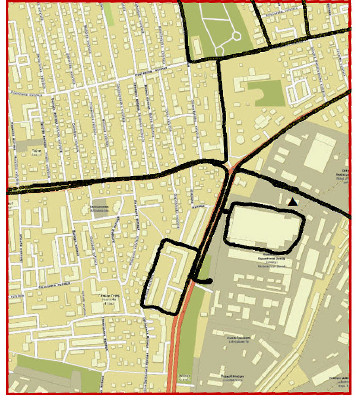
Figure 9. Drive test data within the study